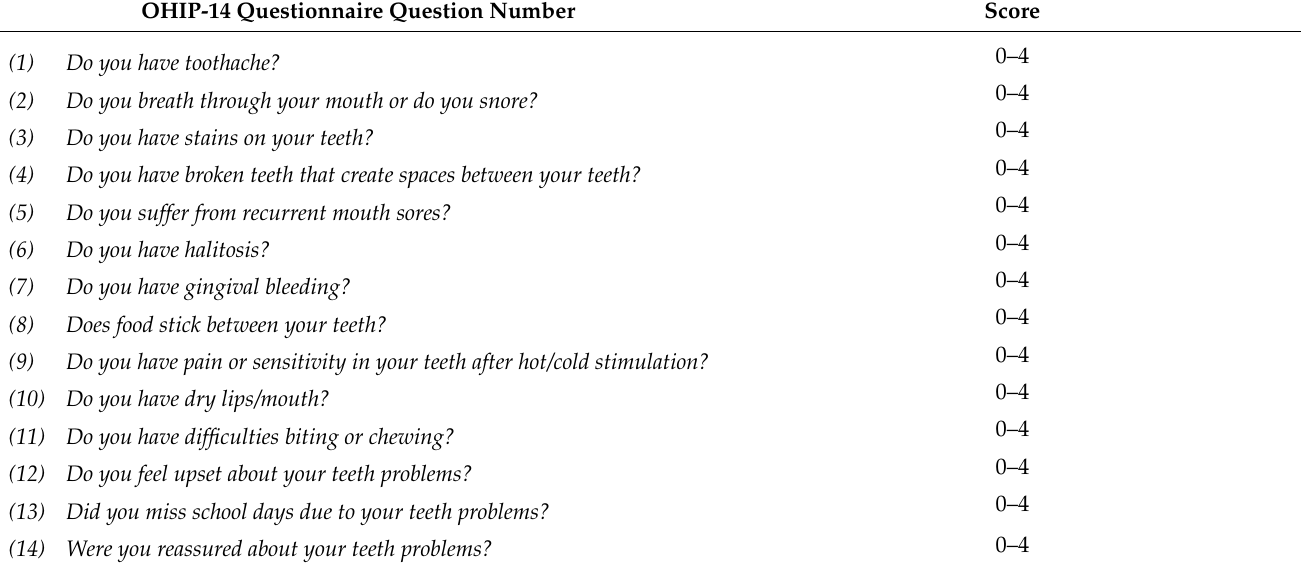
Table 1. OHIP-14 questionnaire